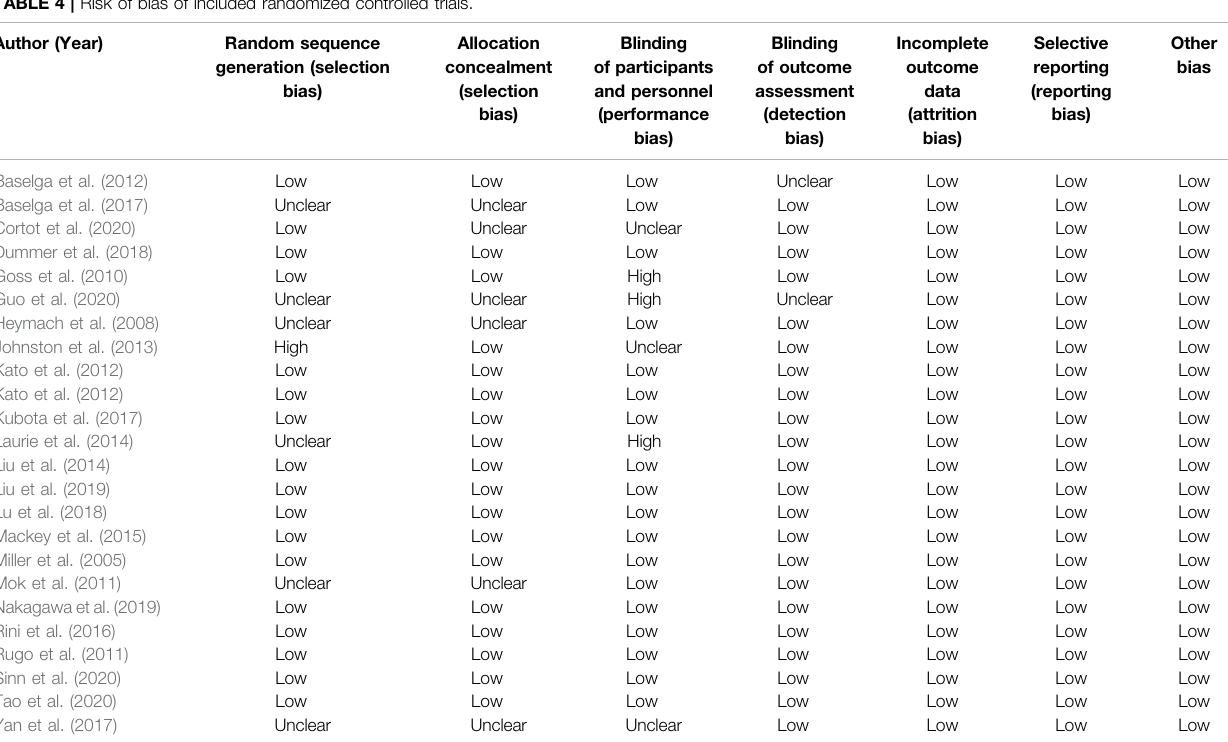
TABLE 4 | Risk of bias of included randomized controlled